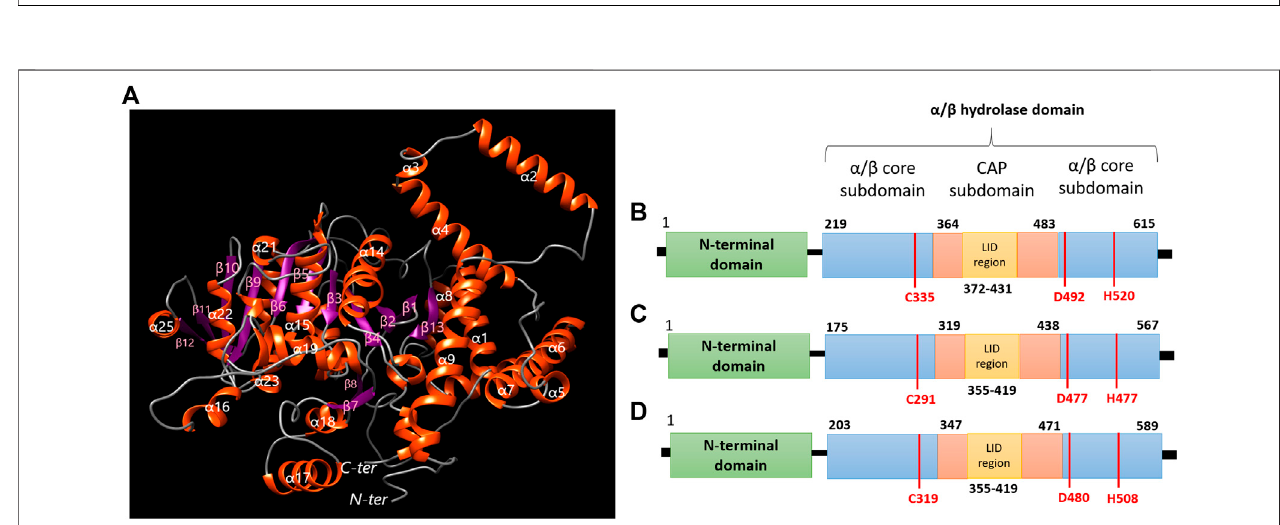
FIGURE 7 | (A) Predicted 3D structure modeling information of polyhydroxyalkanoate synthases of H. desertis G11 generated by Phyre2 server. (B) Domain organization of class I PhaCHd from H. desertis G11 compared to (C) PhaCCs from Chromobacterium sp. USM2 and (D) PhaCCn from Cupriavidus necator .